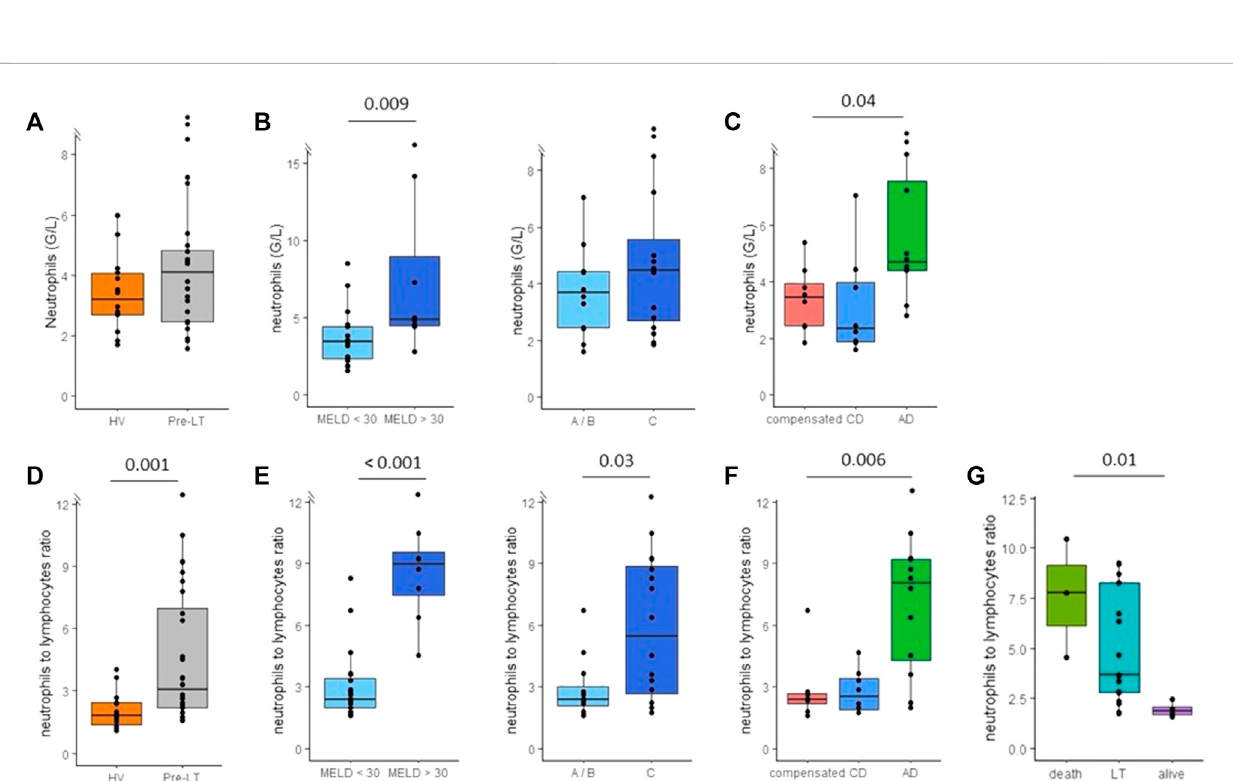
FIGURE 2 Monitoring of neutrophils count and neutrophils to lymphocytes ratio (NLR) in peripheral blood of pre-transplant patients. (A) Neutrophils count in healthy volunteers (HV, n =15) andpre-transplant patients (pre-LT, n = 28). (B) Neutrophilscountinpatients with MELD score < 30( n = 20)orwith MELD score ≥ 30 ( n = 8) and in patients with Child-Pugh score A or B (A/B, n = 12) or with Child-Pugh score C ( n = 16). (C) Neutrophils count in patients with compensated cirrhosis ( n = 8), chronic decompensated cirrhosis (CD, n = 8) and acute decompensated cirrhosis (AD, with n = 10 or without ACLF n = 2). (D) NLR in healthy volunteers (HV) and pre-transplant patients (pre-LT). (E) NLR in patients with or without MELD score < 30 and in patients with Child-Pugh A/B or C. (F) NLR in patients with compensated, chronic decompensated and acute decompensated cirrhosis. (G) NLR according to three months evolution post inclusion. The nonparametric Wilcoxon test was used to assess differences between patients and HV and between patients ’ subgroups determined by MELD and Child-Pugh scores. ANOVA or Kruskal-Wallis tests were used to assess differences between more than 2 independent